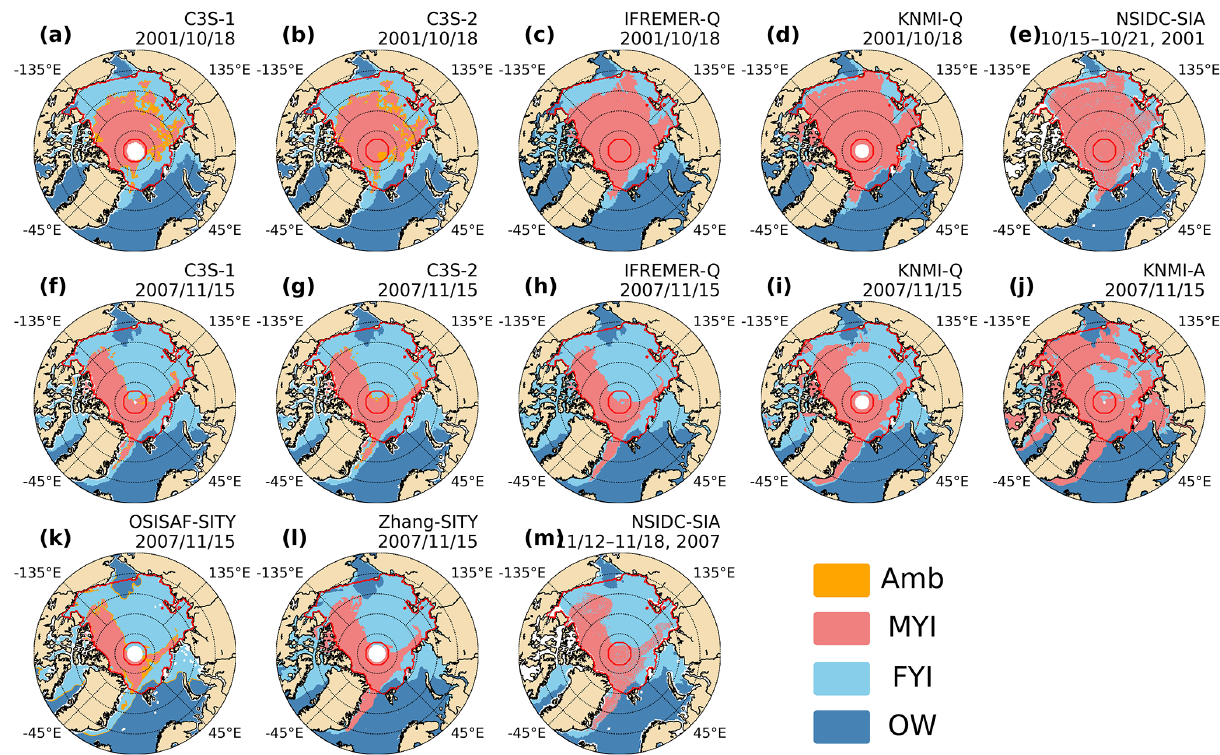
Figure 7. Arctic SITY distribution maps from daily SITY products and weekly NSIDC-SIA on 18 October 2001 (a–e) and 15 Novem- ber 2007 (f–m)